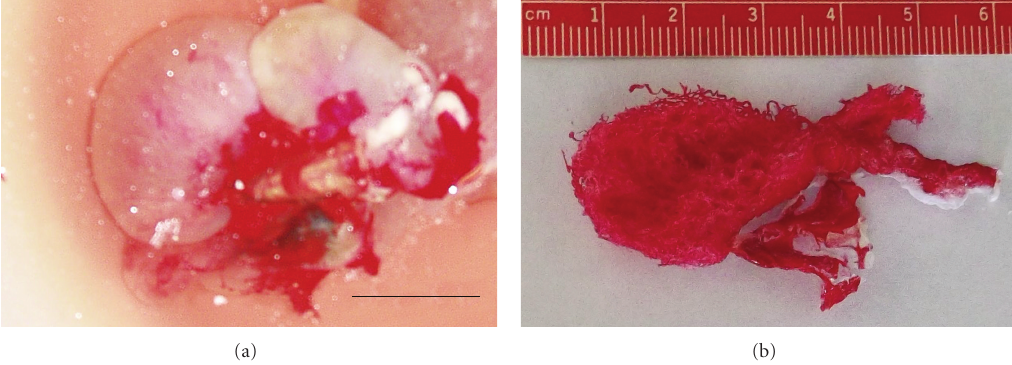
Figure 4: Vascular casting of the right testicular artery within the testis from a virgin two-year-old male llama. This male was routinely castrated, and the testicular artery from the right castrated testes was cannulated. Sixty milliliters of heparinized saline was perfused through the testicular artery and out of the pampiniform plexus (testicular vein). The right testis was perfused with Batson’s no. 17 casting resin as described in Figure 2 to cast the arterial vasculature within the testes. The testis was placed into a 3% potassium hydroxide solution for